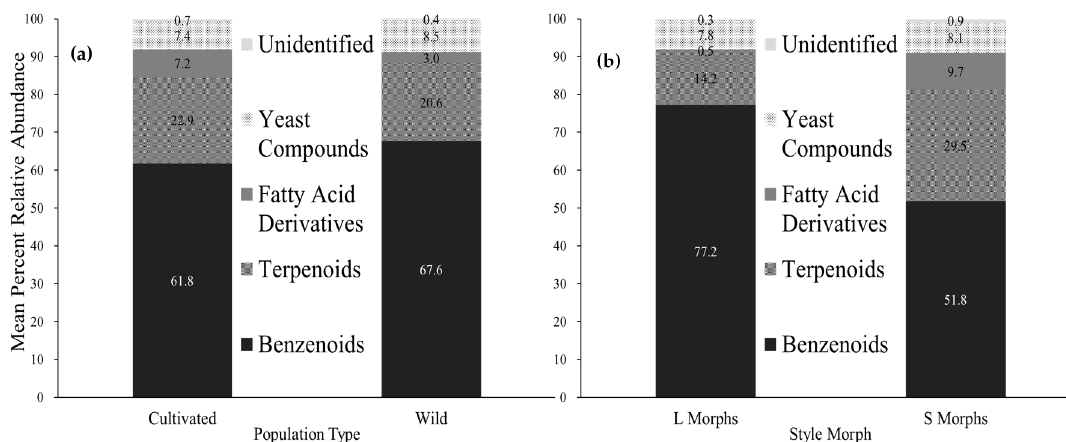
Figure 3. Mean percent relative abundance of compound classes for ( a ) cultivated (N = 35) and wild (N = 39) populations. ( b ) L (N = 38) and S (N = 36) styled flowers.